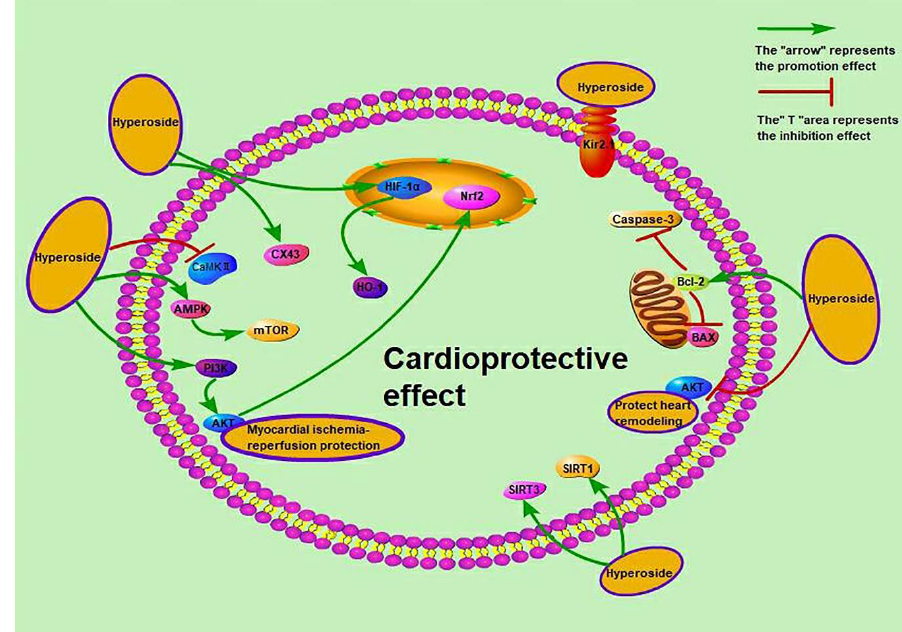
Figure 5. Cardioprotective activity of hyperoside.